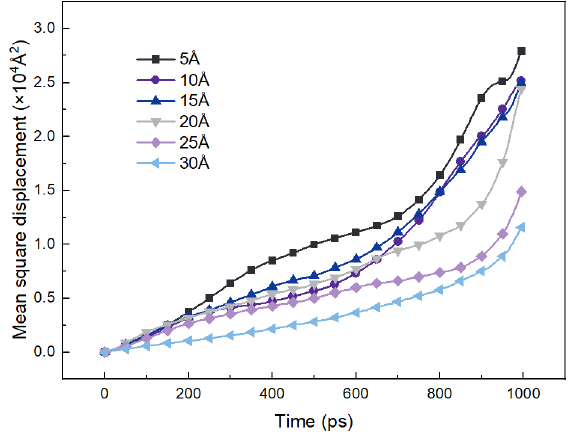
Figure 9. MSD of naphthalene on kaolinite (alumina octahedral surface)/water interface.